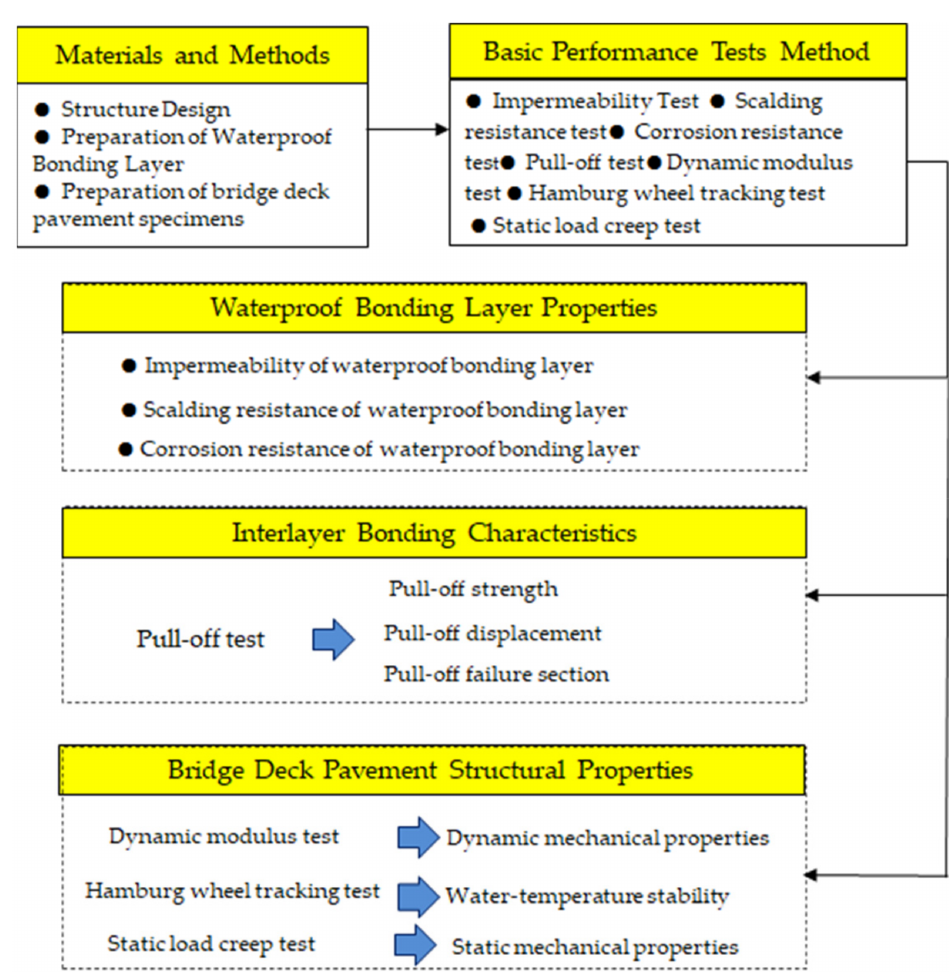
Figure 1. The research